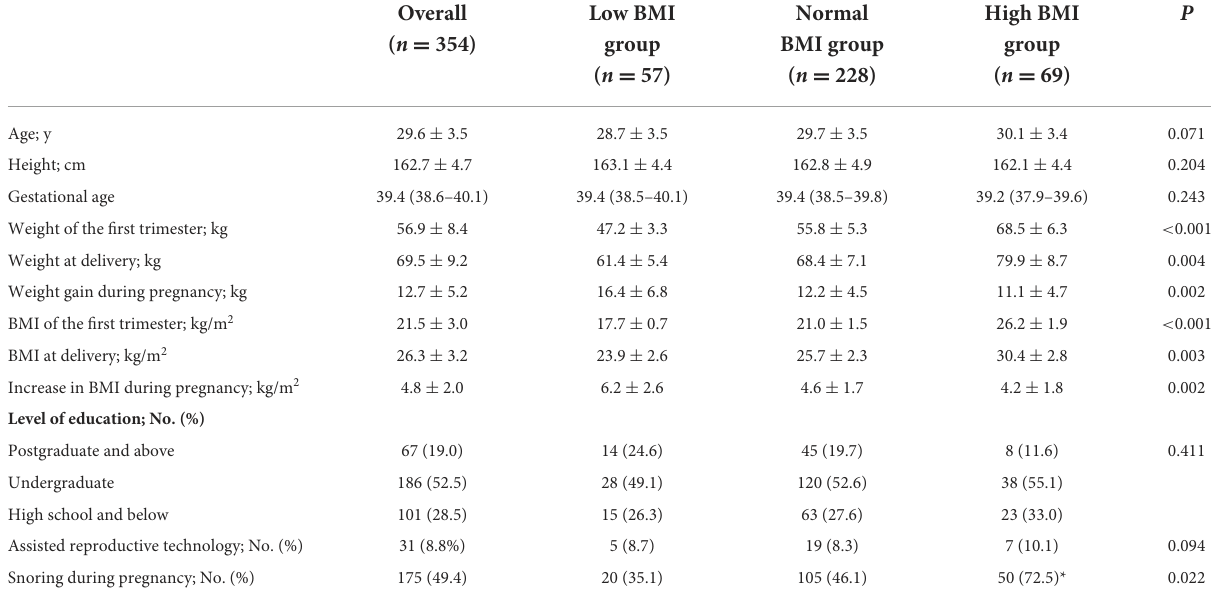
TABLE 1 Baseline characteristics of included women.